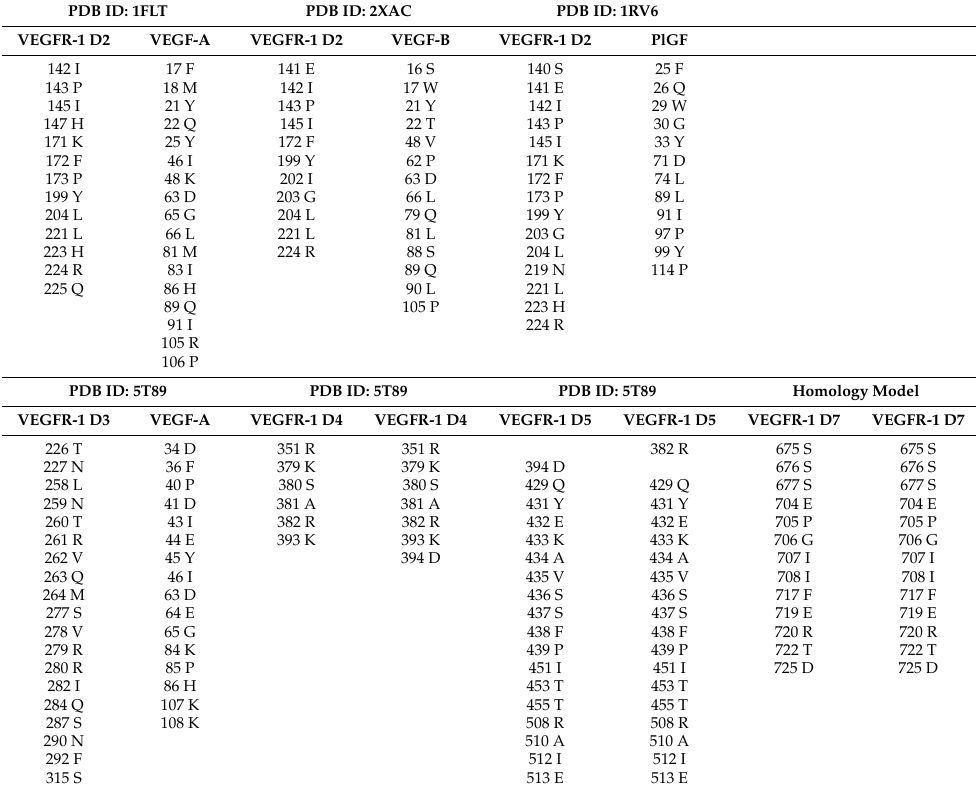
Table 1. VEGFR-1 residues involved in interaction with ligands or dimer